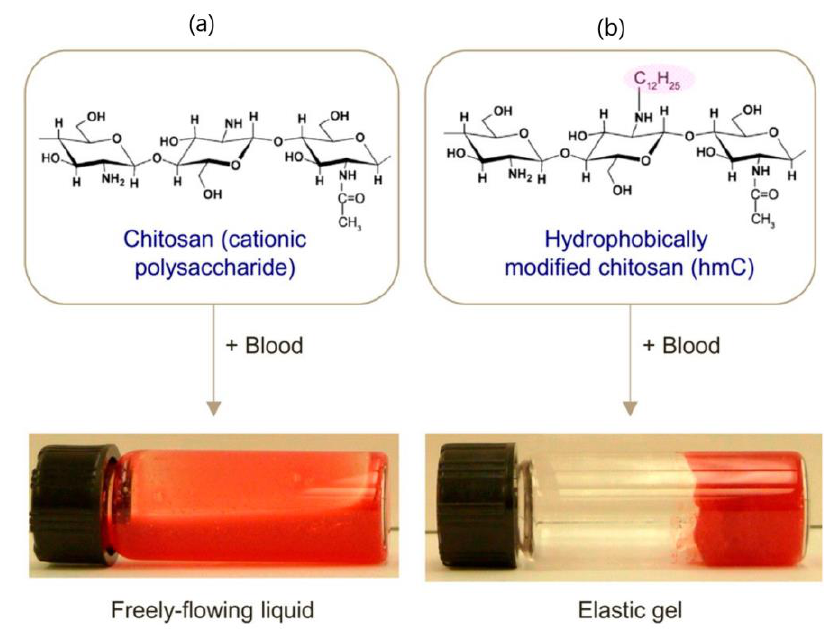
Figure 6. Effect of adding chitosan or hydrophobically modified chitosan (with 5 mol% C12) to bovine blood pretreated with sodium citrate (to prevent clotting), used without dilution. Polymer concentration in both cases was 0.25 wt%. ( a ) Blood remains a flowable liquid when chitosan is added. ( b ) Adding Ch-C12 converts the blood into a gel. The gel has a significant yield stress, which is why it is able to retain its weight in the overturned vial. Reprinted with permission from reference